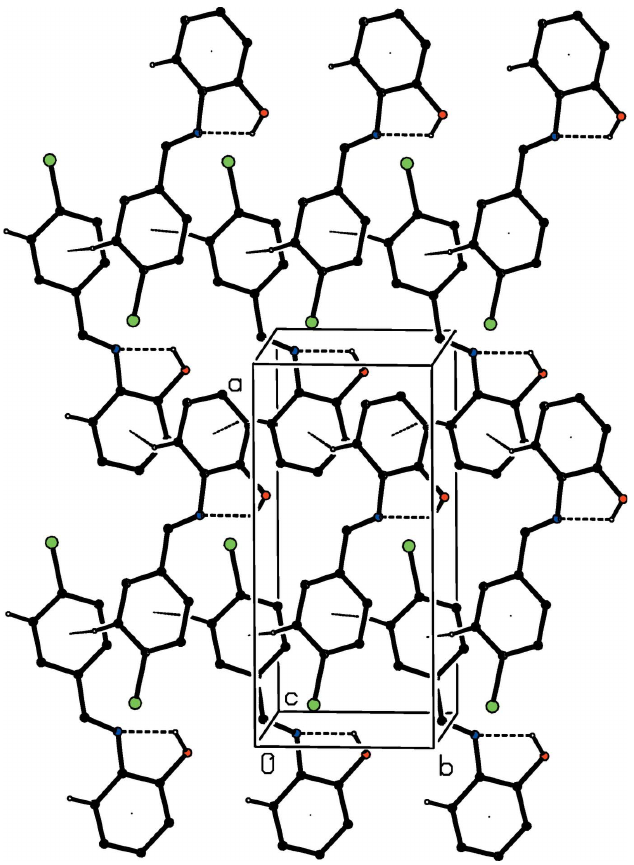
Figure 2 Part of the crystal structure of compound (I), showing the formation of a sheet lying parallel to (001) and built from C—H (cid:2)(cid:2)(cid:2) (cid:2) (arene) hydrogen bonds. For the sake of clarity, H atoms bonded to C atoms but not involved in the motifs shown have been